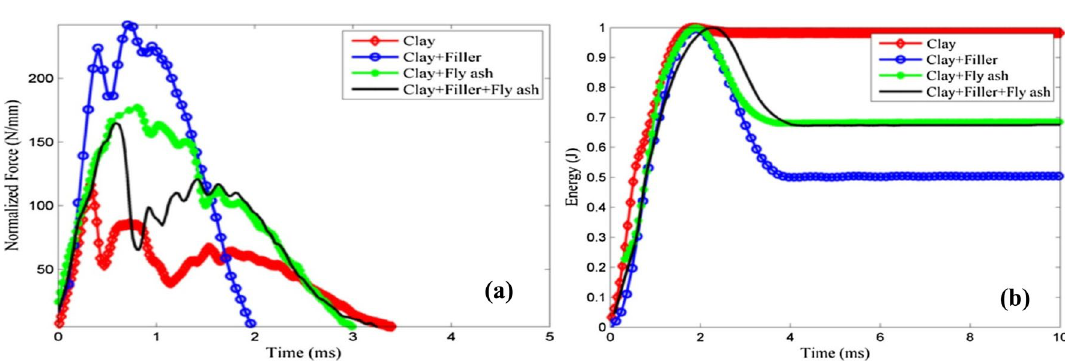
Figure 5. ( a ) Normalized force–time response for one set of samples at 1 J. ( b ) Energy-time response for one set of samples at 1